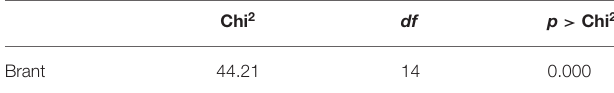
TABLE 6 | Test of parallel regression